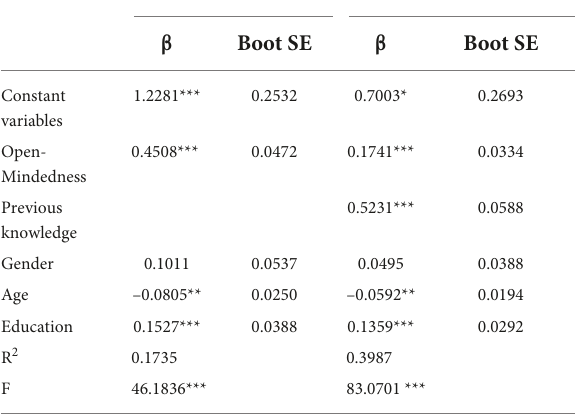
TABLE 4 The mediation effect of previous knowledge between open-mindedness and algorithmic awareness.